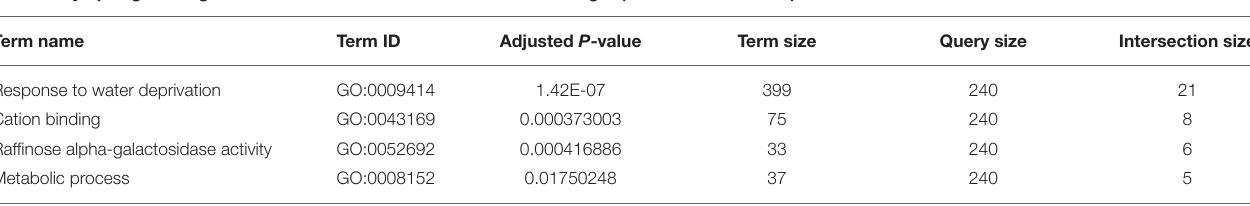
TABLE 2 | GO enrichment of the differentially expressed genes in Otis and Baronesse under drought compared to well-watered control (OD-OW and BD-BW). Commonly up-regulated genes between Otis and Baronesse under drought (OD-OW and